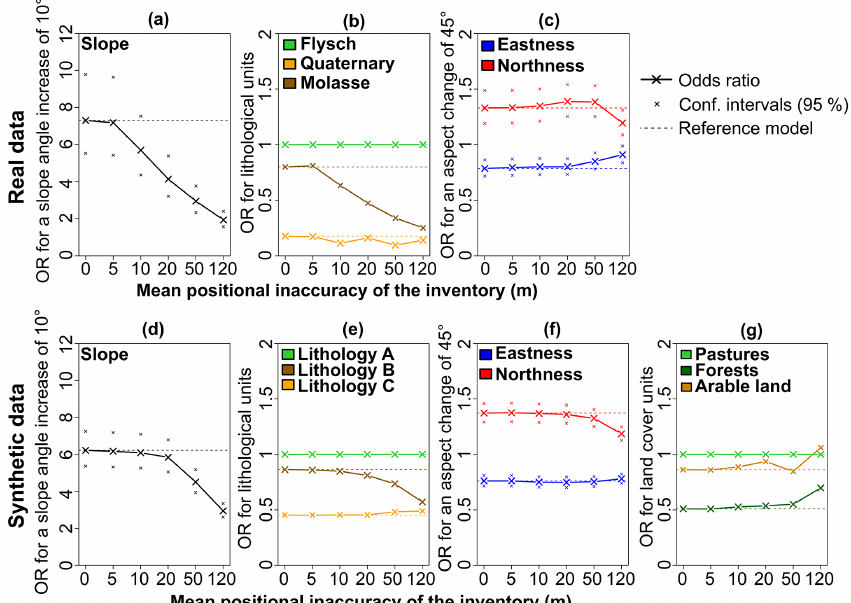
Figure 4. Estimated odds ratios (OR) for the models generated with differently accurate landslide inventories. ORs obtained for the predictors slope (a, d) , northness (c, f) , eastness (c, f) and land cover (g) suggested a decreasing estimated effect of topographic and land cover variations on modelling results with an increasing positional error of the inventory (i.e. ORs are approaching the no-effect threshold value 1). ORs of the lithology classes revealed decreasing modelled chances that the Molasse (b) respectively the unit B (e) may be affected by future